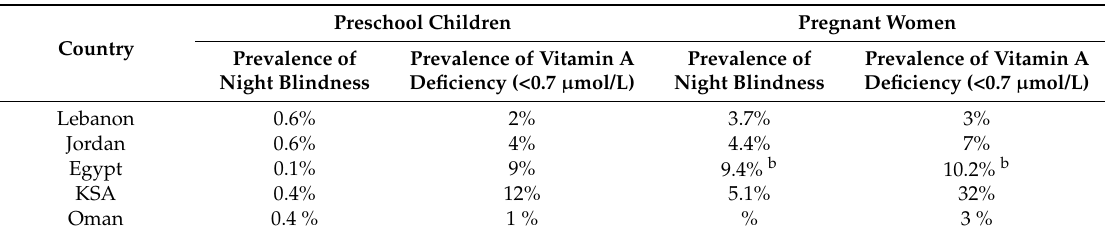
Table 1. Country estimates of the prevalence of night blindness and vitamin A deficiency in preschool children and pregnant women (1995–2005) a